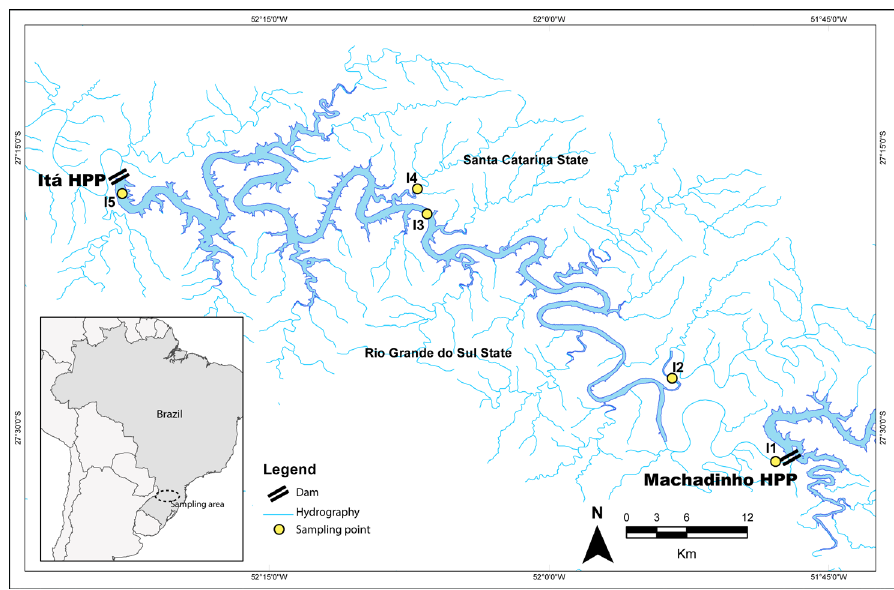
Figure 1. Sampling sites of eDNA plankton samples collected in the Itá reservoir, Upper Uruguay River, in Southern